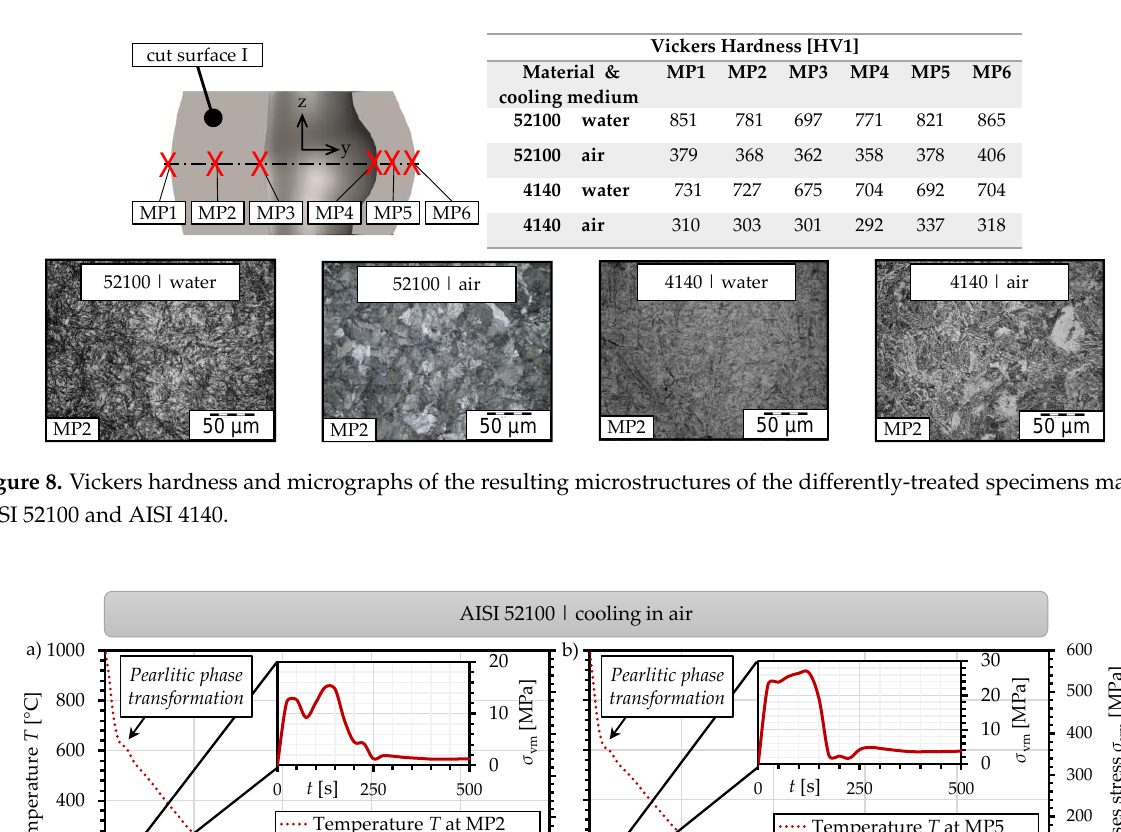
Figure 8. Vickers hardness and micrographs of the resulting microstructures of the differently-treated specimens made of AISI 52100 and AISI 4140.